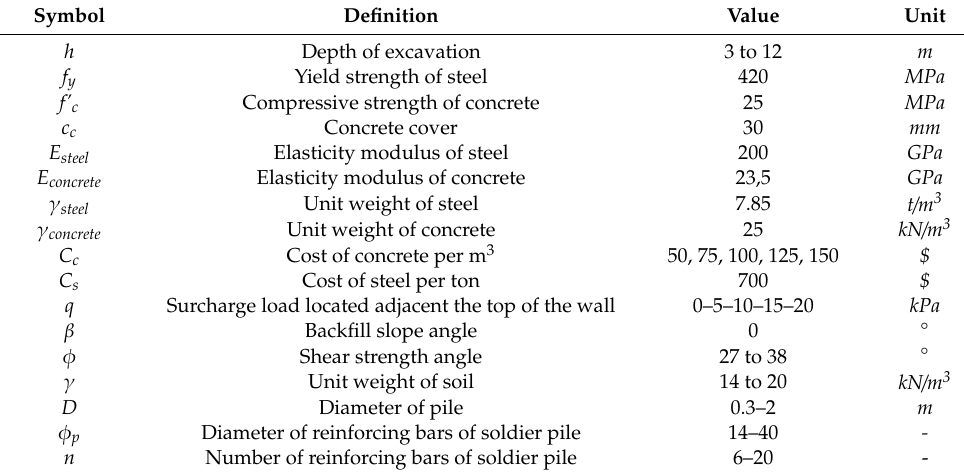
Table 3. The design constants and design variables of cantilever soldier